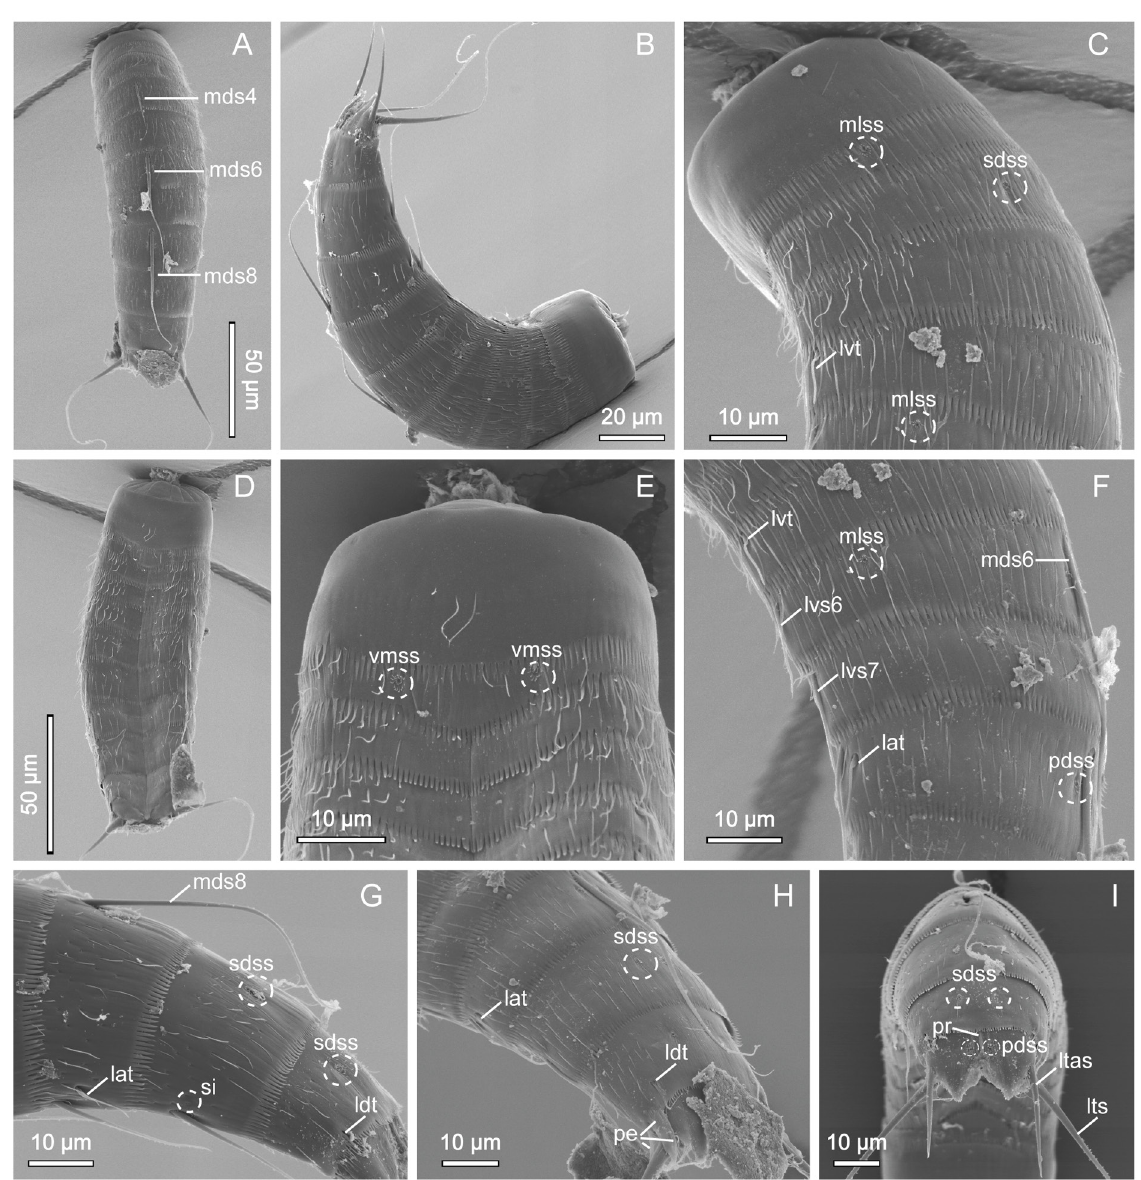
Fig. 22. Scanning electron micrographs showing overviews and details of Echinoderes samwisei sp. nov. A . Dorsal overview of male. B . Lateral overview of female. C . Segments 1 to 5, lateral view. D . Ventral overview of male. E . Segments 1 to 5, ventral view. F . Segments 5 to 8, lateral view. G . Segments 8 to 10 of female, lateral view. H . Segments 8 to 11 of male, lateral view. I . Segments 9 to 11 of female, dorsal view. Abbreviations: see Material